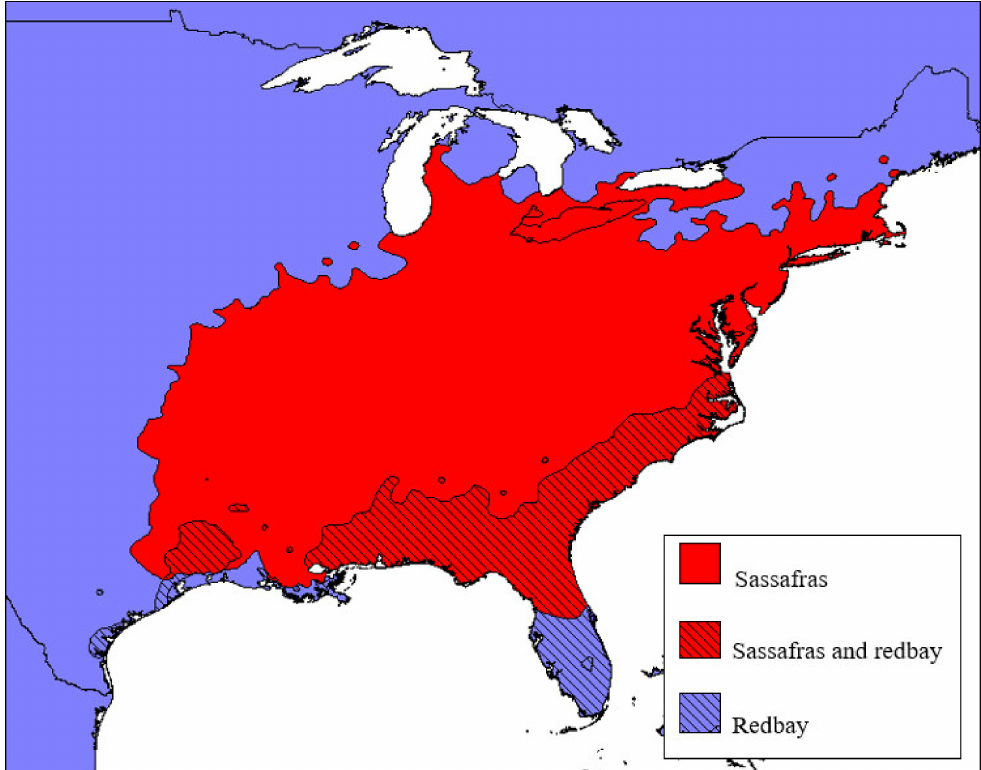
Figure 4. The geographic distribution maps of redbay ( Persea borbonia ) and sassafras ( Sassafras albidum ) in the United States, including possible overlaps between the two